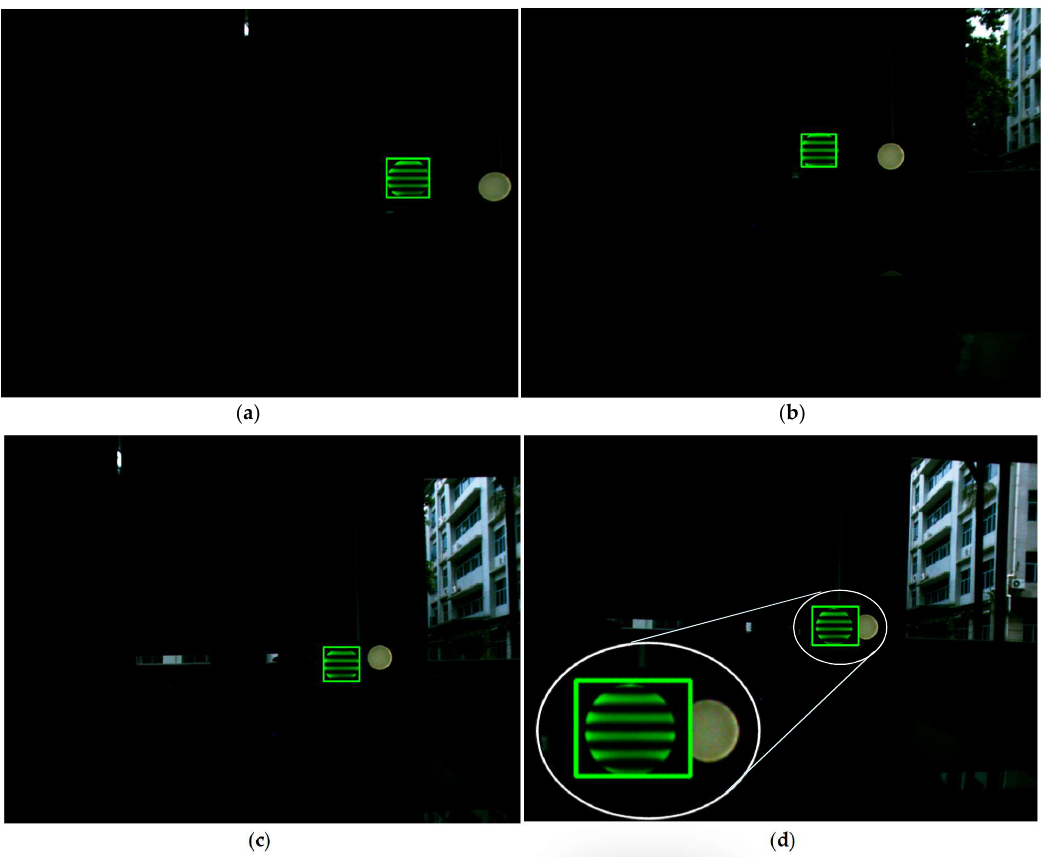
Figure 13. Tracking performance of the proposed algorithm under similar color interference and background interference: ( a ) frame number 63, ( b ) frame number 74, ( c ) frame number 86, and ( d ) frame number 91.